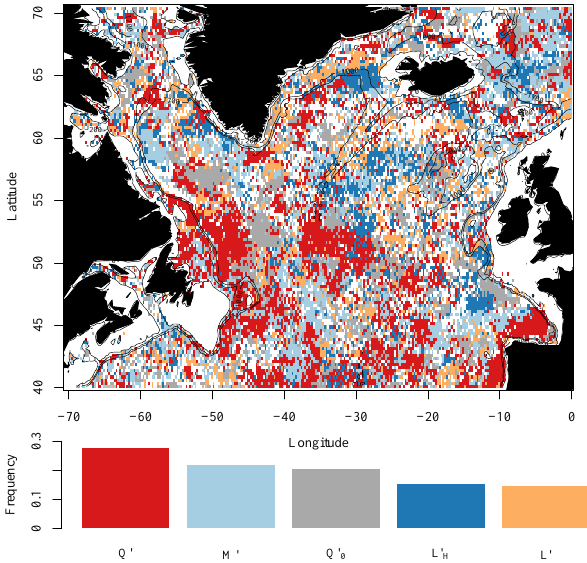
Figure 4. Selected variable for each 0 . 25 ◦ pixel (top) and relative frequency of each single-variable model (bottom). PAR integrated to the MLD: L (cid:48) ; PAR: L (cid:48) ; wind-driven mixing: M (cid:48) ; heat flux: Q (cid:48) H and start of net warming: Q (cid:48) . Only pixels where the weight of the 0 winner model is higher than 30% and the bottom depth exceeds 200m are used in this